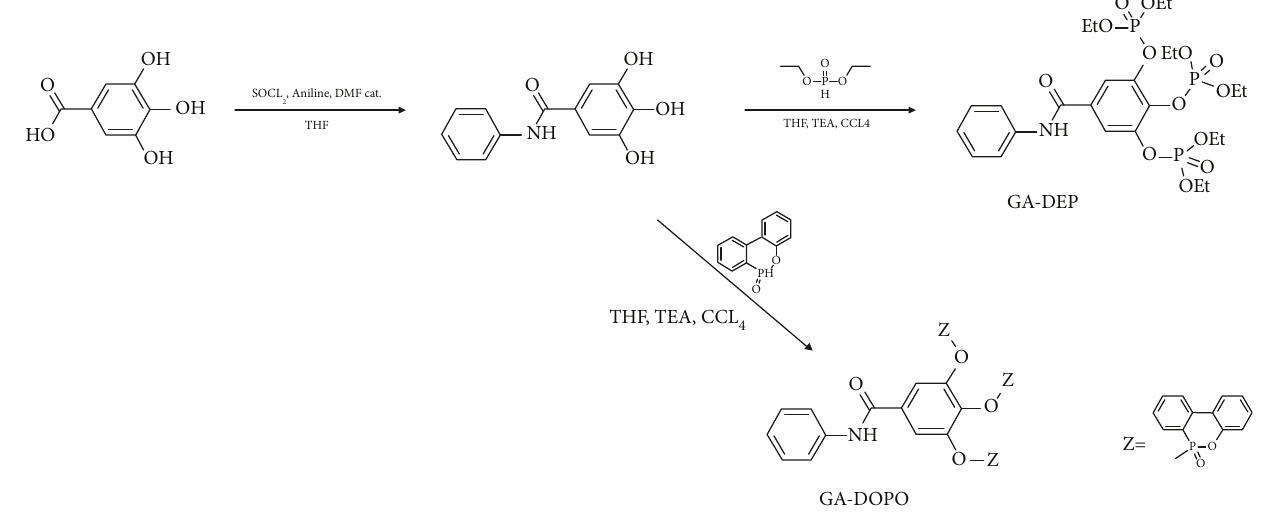
Scheme 1: Synthesis of phosphorus esters of gallic Table 1: Thermal decomposition of phosphorous esters of gallic acid anilide.